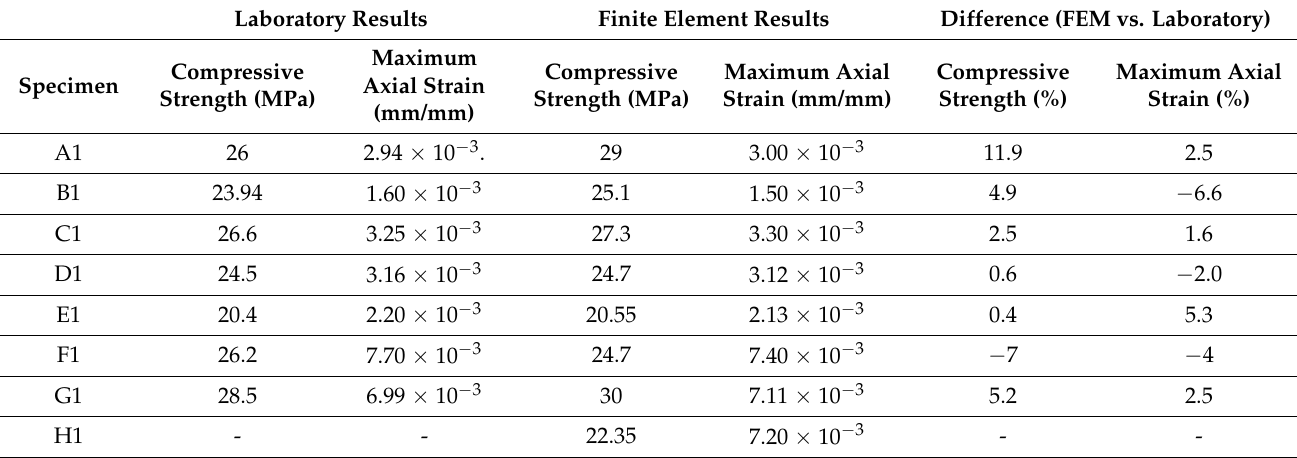
Table 2. Difference Between the Finite Element and Laboratory Results.